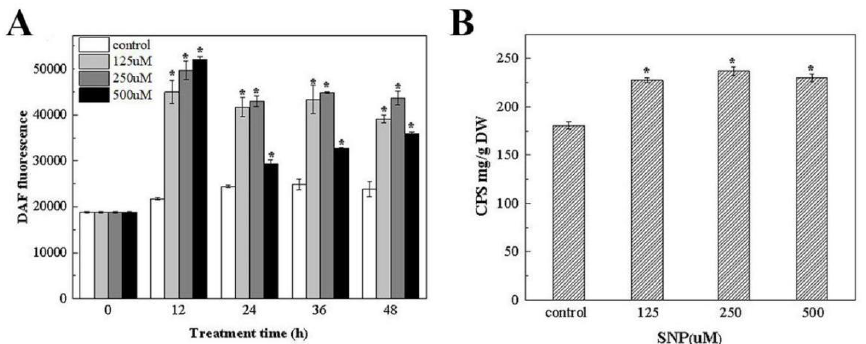
Figure 6. The effect of different SNP concentrations on the NO content ( A ) and the polysaccharide production ( B ) of N. flagelliforme . * p < 0.05, compared with the control group. Compared with the control group without SNP treatment, the CPS of the experi- mental groups with different concentrations of SNP increased significantly, and the poly- saccharide production of the experimental groups with 125, 250, and 500 μM SNP in- creased by 26%, 32%, and 28%, respectively, compared with the control group (Figure 6B). A previous study reported that NO acts as a signaling molecule that promotes the pro- duction of certain metabolites [39]. Therefore, the above results showed that extrinsically added NO released from SNP at different concentrations promoted polysaccharide syn- thesis in N. flagelliforme .